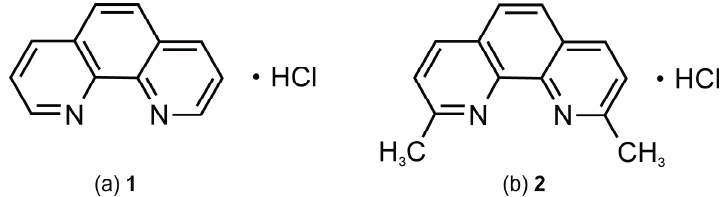
Figure 1. Molecular diagrams of ( a ) 1,10-phenanthroline hydrochloride ( 1 ) and ( b ) neocuproine HCl ( 2 ).